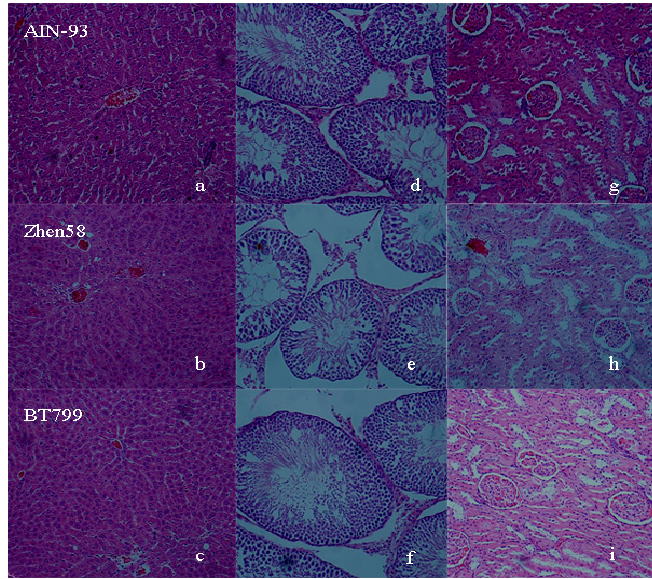
Figure 3. Photomicrographs of liver ( a – c ); kidney ( d – f ) and testis ( g – i ) tissues of male rats stained with H&E × 200. The rows ( a – g) , ( b – h ) and ( c – i ) were tissues from the AIN-93G control group, Zhen58 group and BT799 group, respectively.